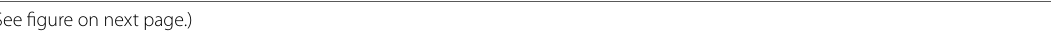
dermatitis(See figure on next Fig. 6 Concordance between rhinoconjunctivitis and/or asthma ever, AD severity (moderate or severe), elevated total plasma IgE and positive Phadiatop. a 173 AD patients, b 84 AD patients with IgG-reactivity to KRTAP17-1 HSPA4, S100A12 and/or S100Z, c 55 AD patients with IgG-reactivity to KRTAP-17, d 36 AD patients with IgG-reactivity to HSPA4, e 13 AD patients with IgG-reactivity to S100A12, f 8 AD patients with IgG-reactivity to S100Z, and g 89 AD patients without IgG-reactivity to any of the antigens for KRTAP17-1 HSPA4, S100A12 and/or S100Z. IgG-reactivity based on analysis of the complete cohort using targeted antigen bead arrays, showing frequencies. Elevated total plasma IgE defined as atopic